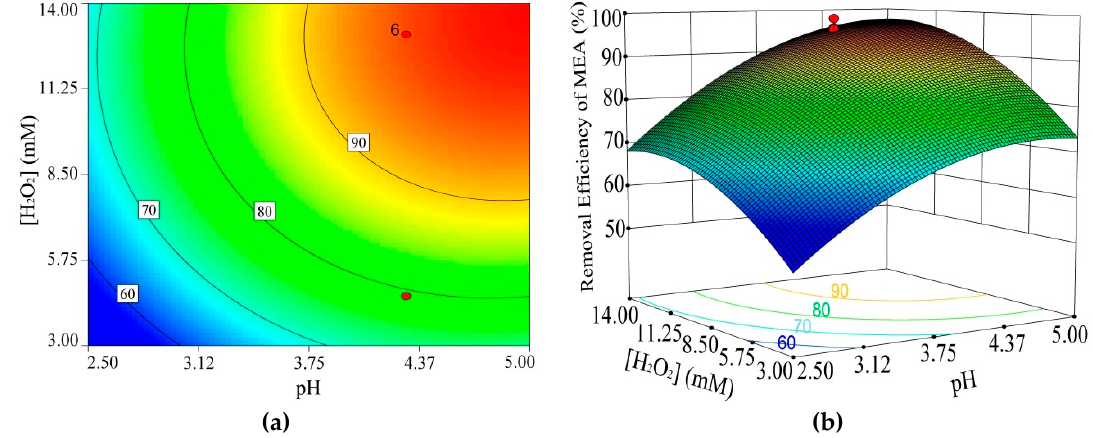
Figure 7. Response surface plots for the t pH and [H 2 O 2 ] at 32.00 °C. ( a ) Contour, ( b ) 3D surface.